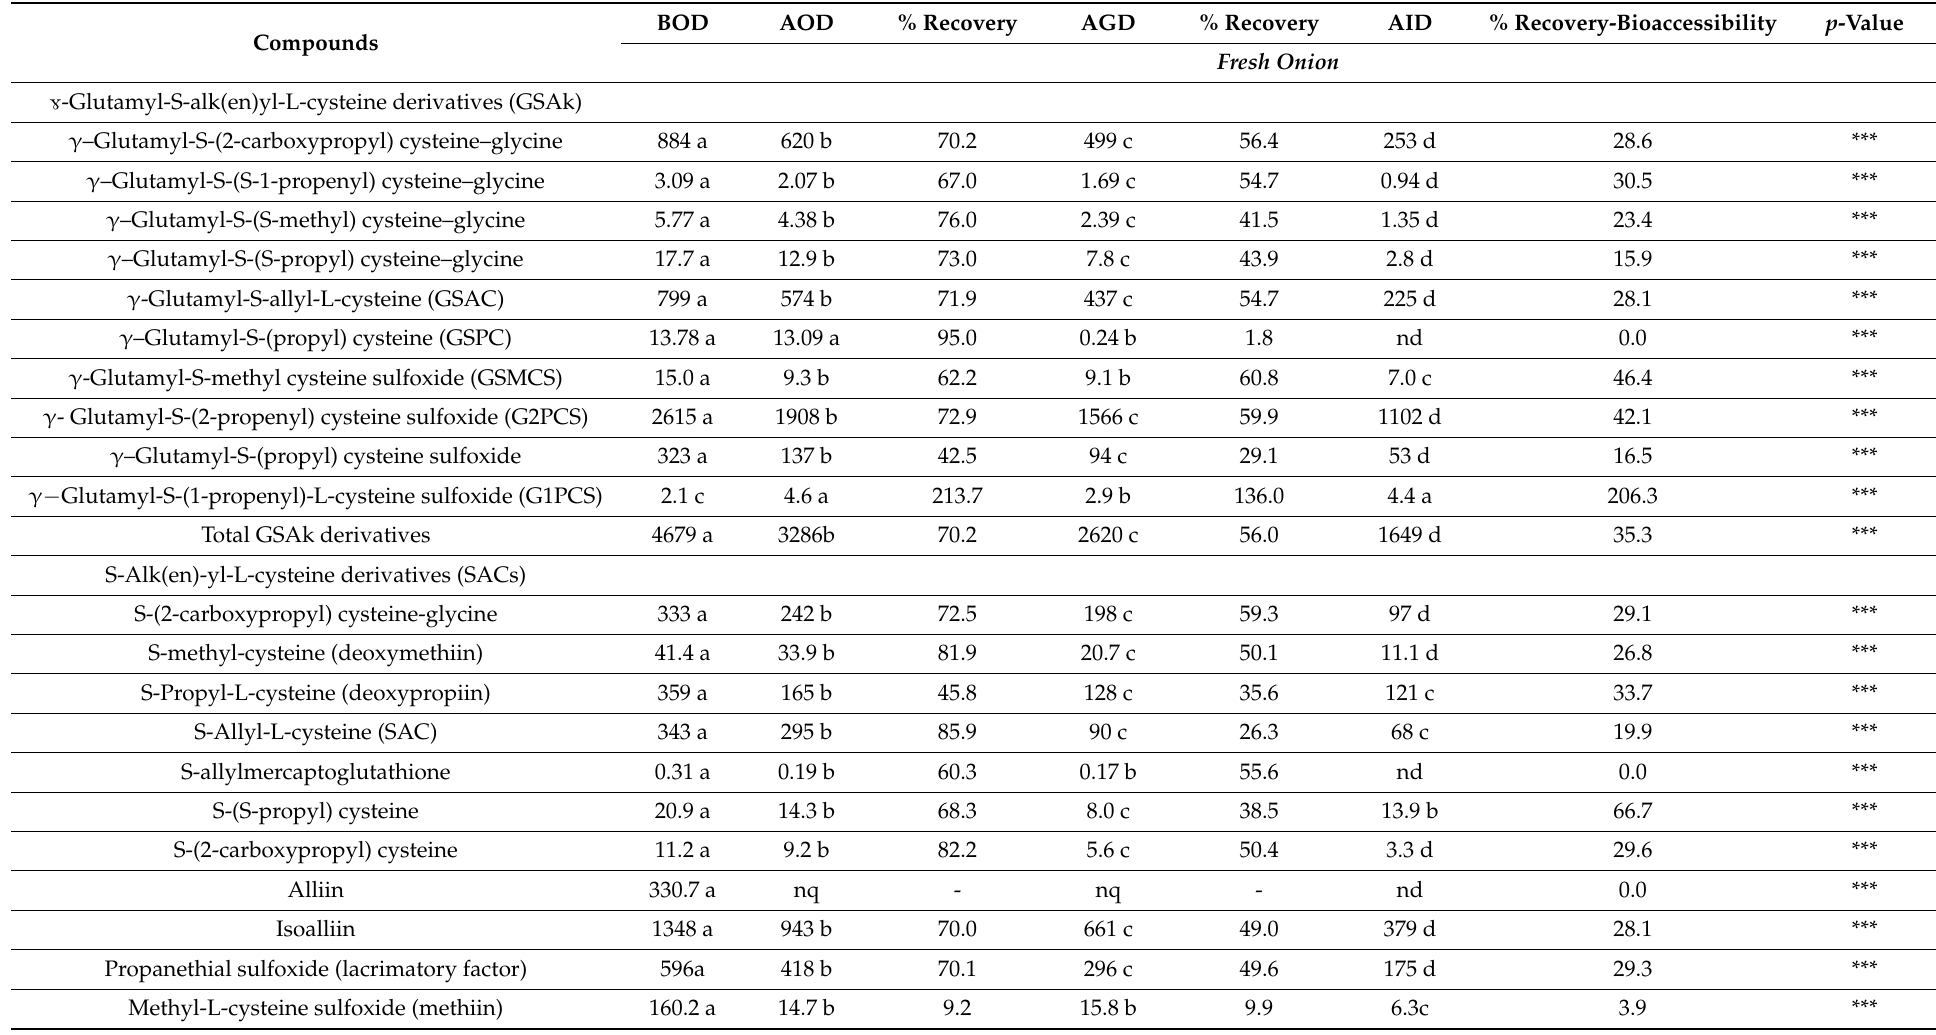
Table 3. Concentrations (nmol/g FW) of organosulfur compounds in fresh and black onion samples at different stages of simulated gastrointestinal digestion. Data are expressed as mean values ( n =